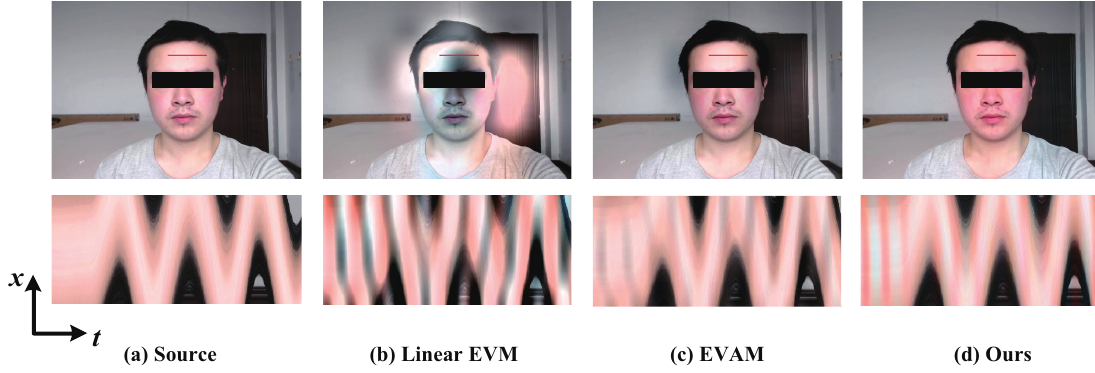
Figure 2. Comparison of the color magnification results on face sequence in presence of a nonlinear motion. ( a ) Top: An original frame from the input video. Bottom: A spatio-temporal X − T slice of the video along the red line marked on the input frame. ( b ) The linear EVM [6] intensity processing result and the corresponding spatio-temporal slice. ( c ) Color magnification using video acceleration magnification [17] and the X − T slice along the red line. ( d ) Our result of video color magnification and the temporal variation at the location indicated by the red stripe. Note that our algorithm is better able to magnify the intensity for video with a non-linear